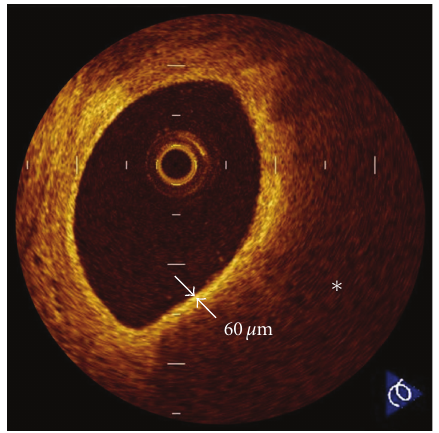
Figure 2: Plaque erosion. Erosion (arrowhead) is usually comprised of OCT evidence of thrombi (arrows), an irregular luminal surface, and no evidence of cap rupture evaluated in multiple adjacent frames. The characteristic of OCT features of erosions are a thick intima and a small or absent lipid core. If the lipid core is present, it does not communicate with luminal thrombi.